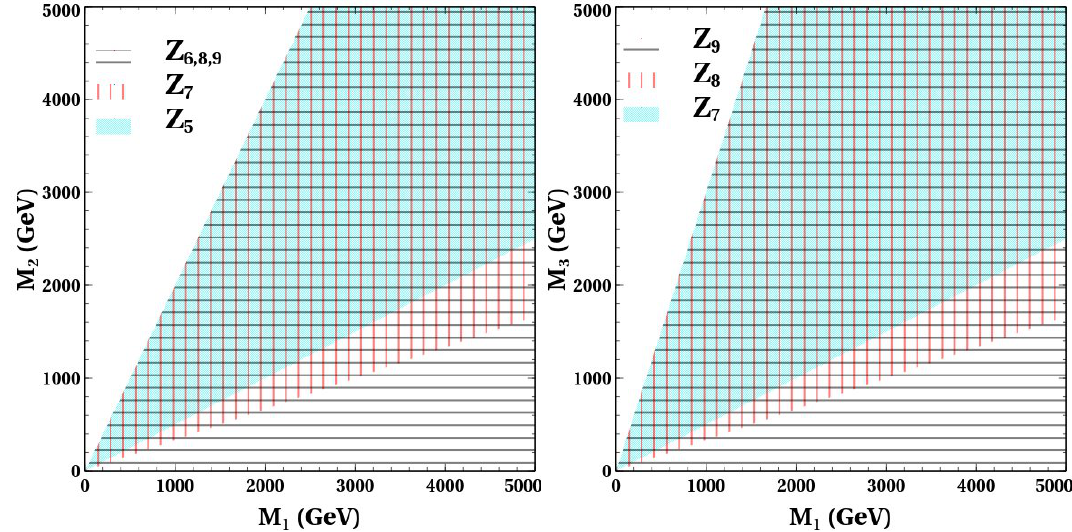
Figure 1 . Left (right): regions in the plane ( M 1 ; M 2 ) where (cid:30) 1 and (cid:30) 2 (in the plane ( M 1 ; M 3 ) where (cid:30) 1 and (cid:30) 3 ) are both simultaneously stable for di(cid:11)erent Z N symmetries. 3.3.1 Two